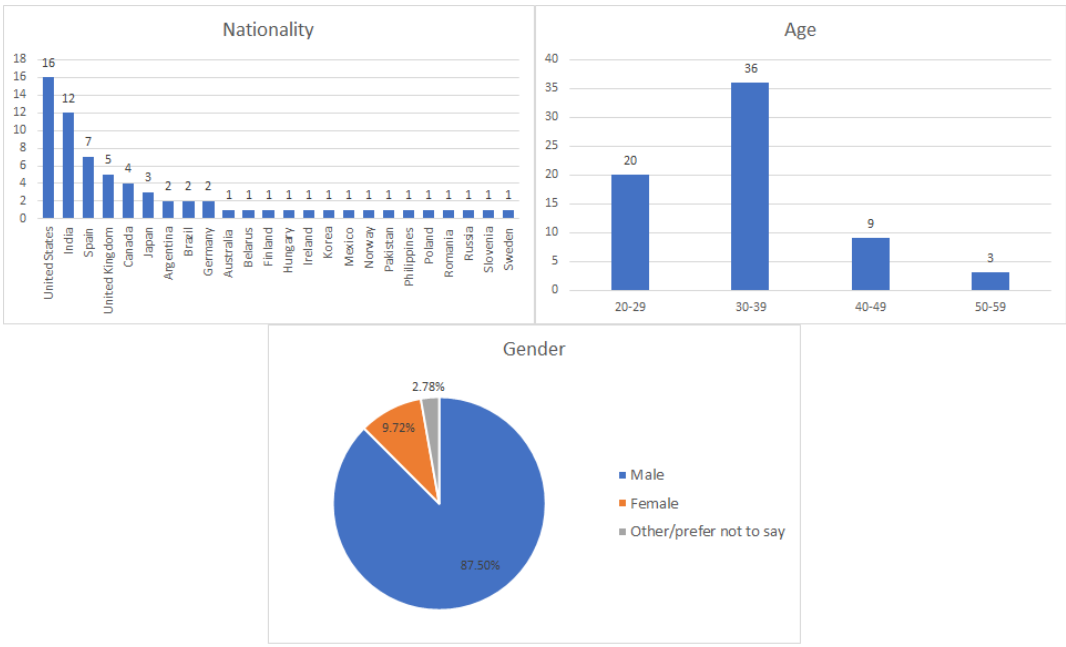
Figure 5. Figures showing the total number of participants per nationality, age, and